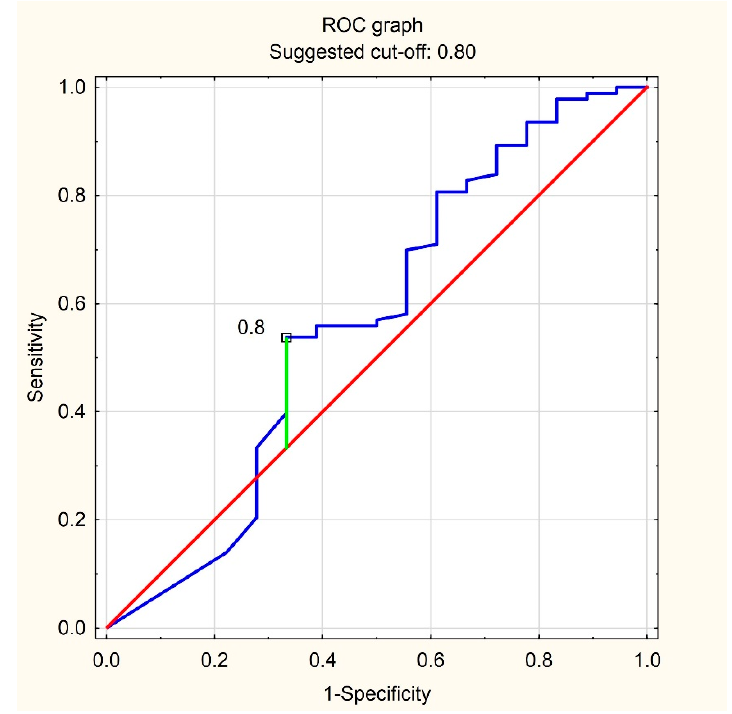
Figure 1. ROC graph.